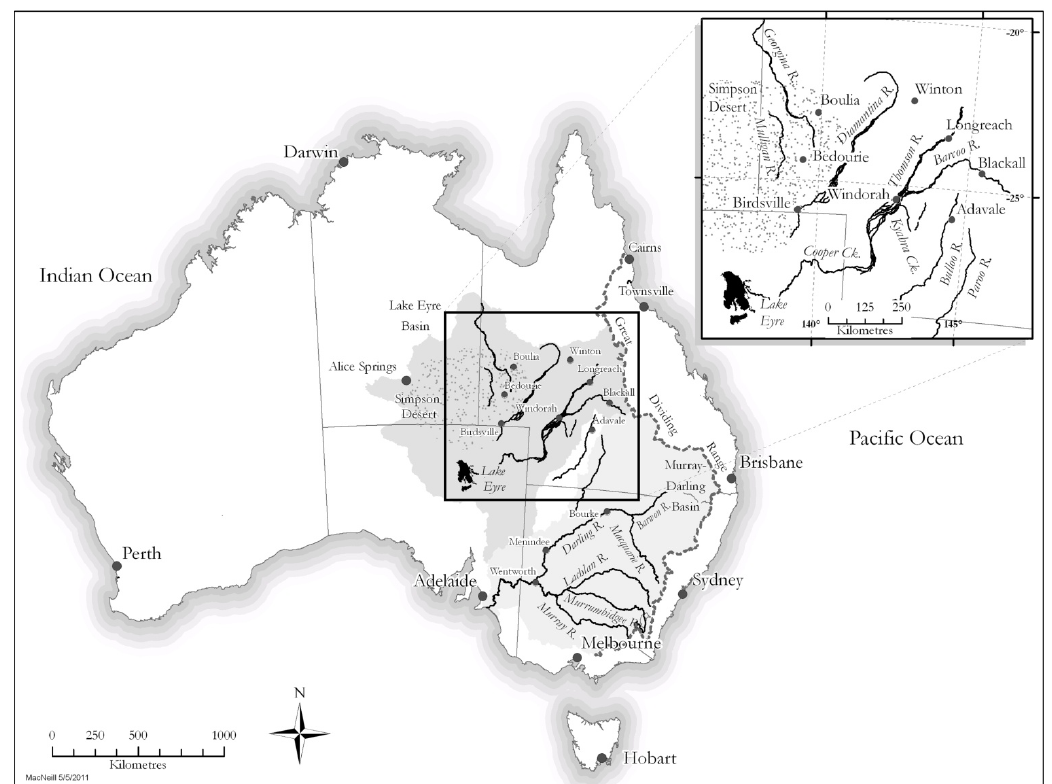
Figure 1. Site map showing the location of the study area within central Australia and